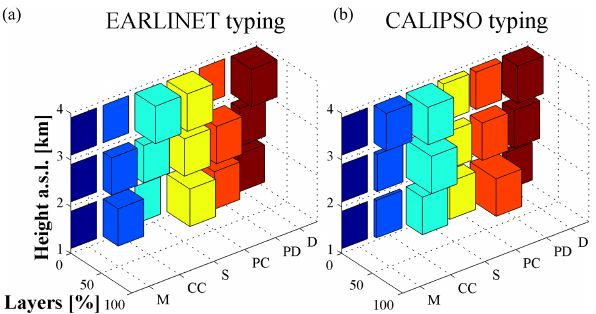
Figure 8. Leipzig: (a) EARLINET and (b) CALIPSO typing bar plots for 1km range increment. M stands for marine, D for dust, PC for polluted continental, CC for clean continental, PD for polluted dust, and S for smoke